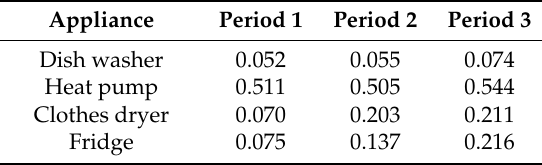
Table 4. Power contribution error (PCE) (%) for four appliances from three periods.